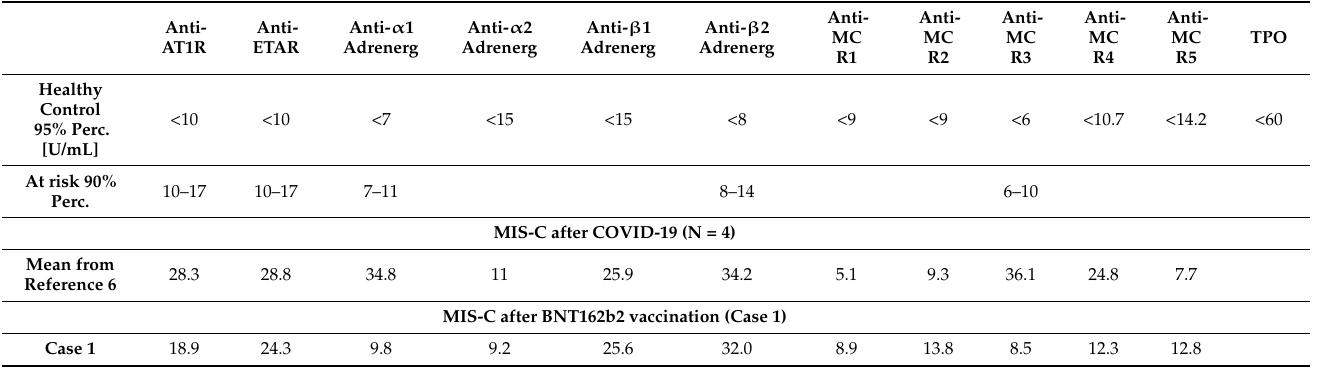
Table 1. Autoantibodies after vaccination, compared to children with MIS-C after COVID-19, as recently published [6]. Anti-